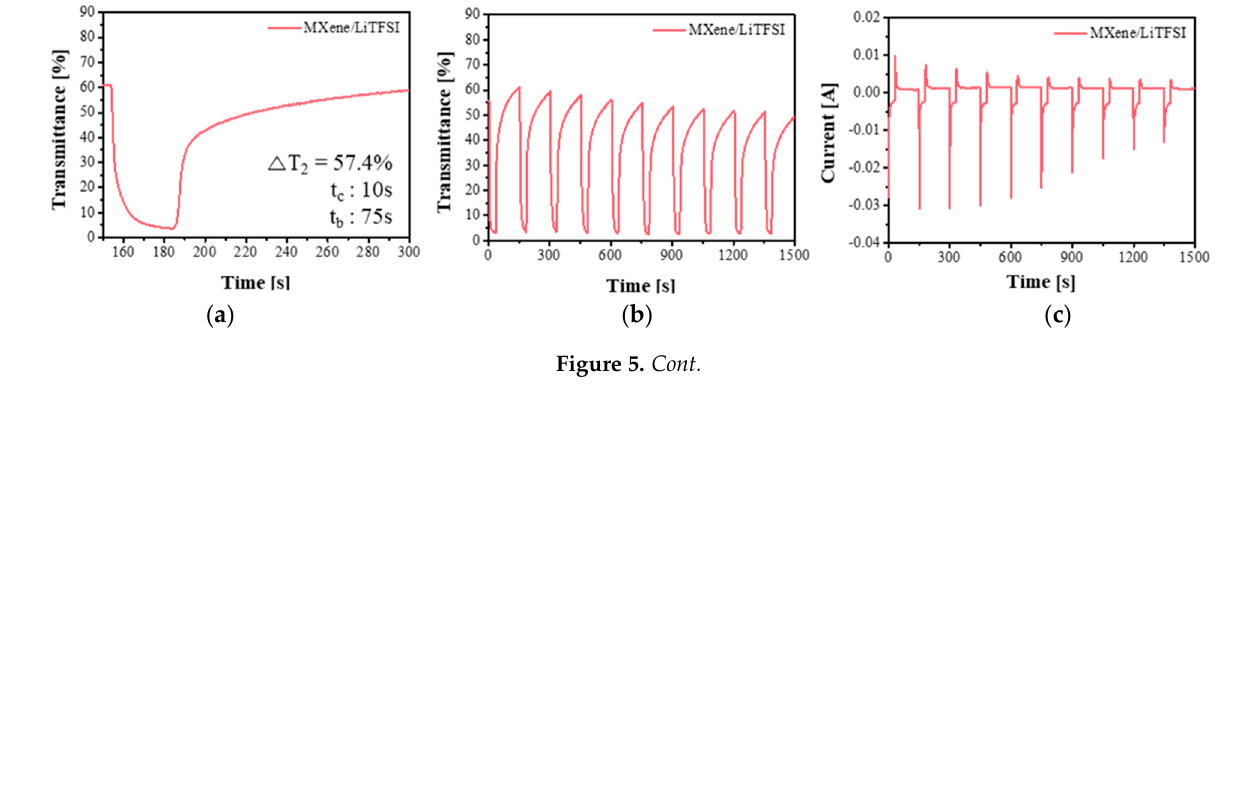
Figure 4. Cyclic voltammetry of ( a ) MXene/Bis(trifluoromethylsulfonyl)amine lithium salt (MXene/LiTFSI), ( b ) poly(4- styrenesulfonic acid) crosslinked with MXene (M-PSSA) and ( c ) 1:20 LiTFSI in MXene-PSSA(M-PSSA/LiTFSI) at different scan rates, and the corresponding transmittance vs time at the wavelengths of 600 nm for ( d ) 20 mV s − 1 , ( e ) 50 mV s − 1 , and ( f ) 100 mV s − 1 .